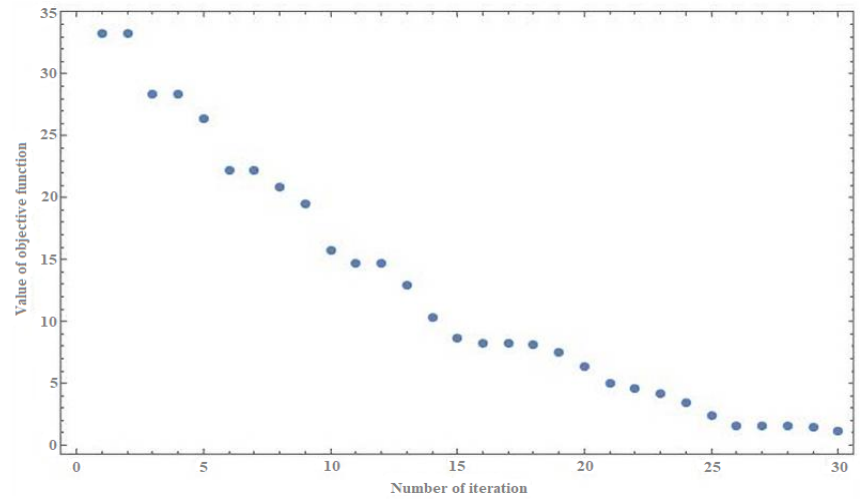
Figure 3. Values of the objective function in subsequent iterations of the algorithm.